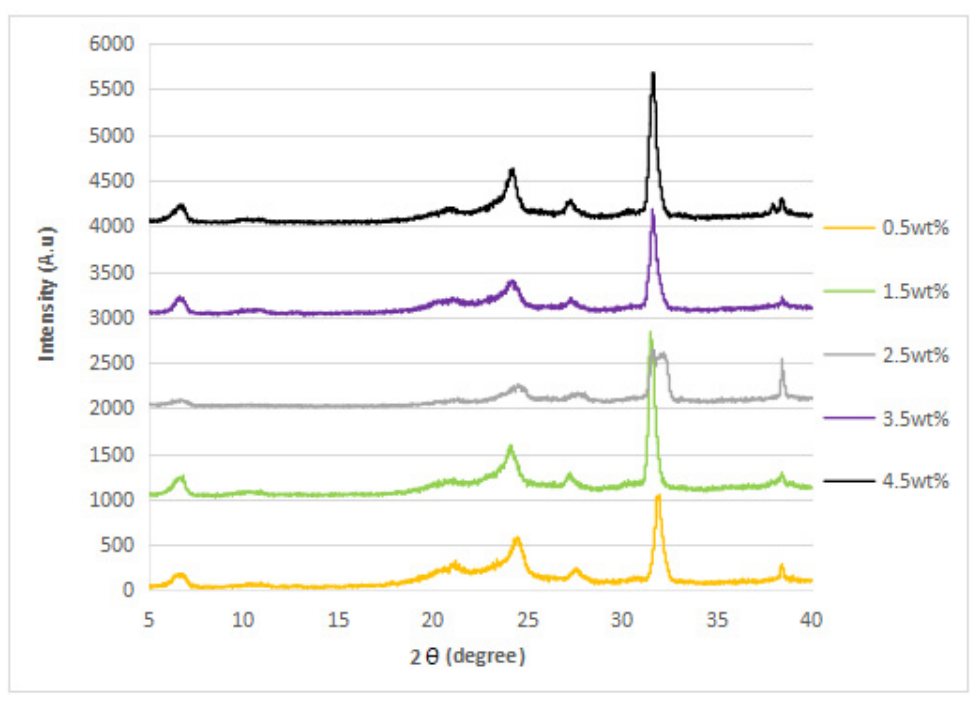
Figure 5. XRD Spectra of Nylon 610 Nanocomposites with Treated Graphite Flakes at 175 °C and − 0.08 MPa.